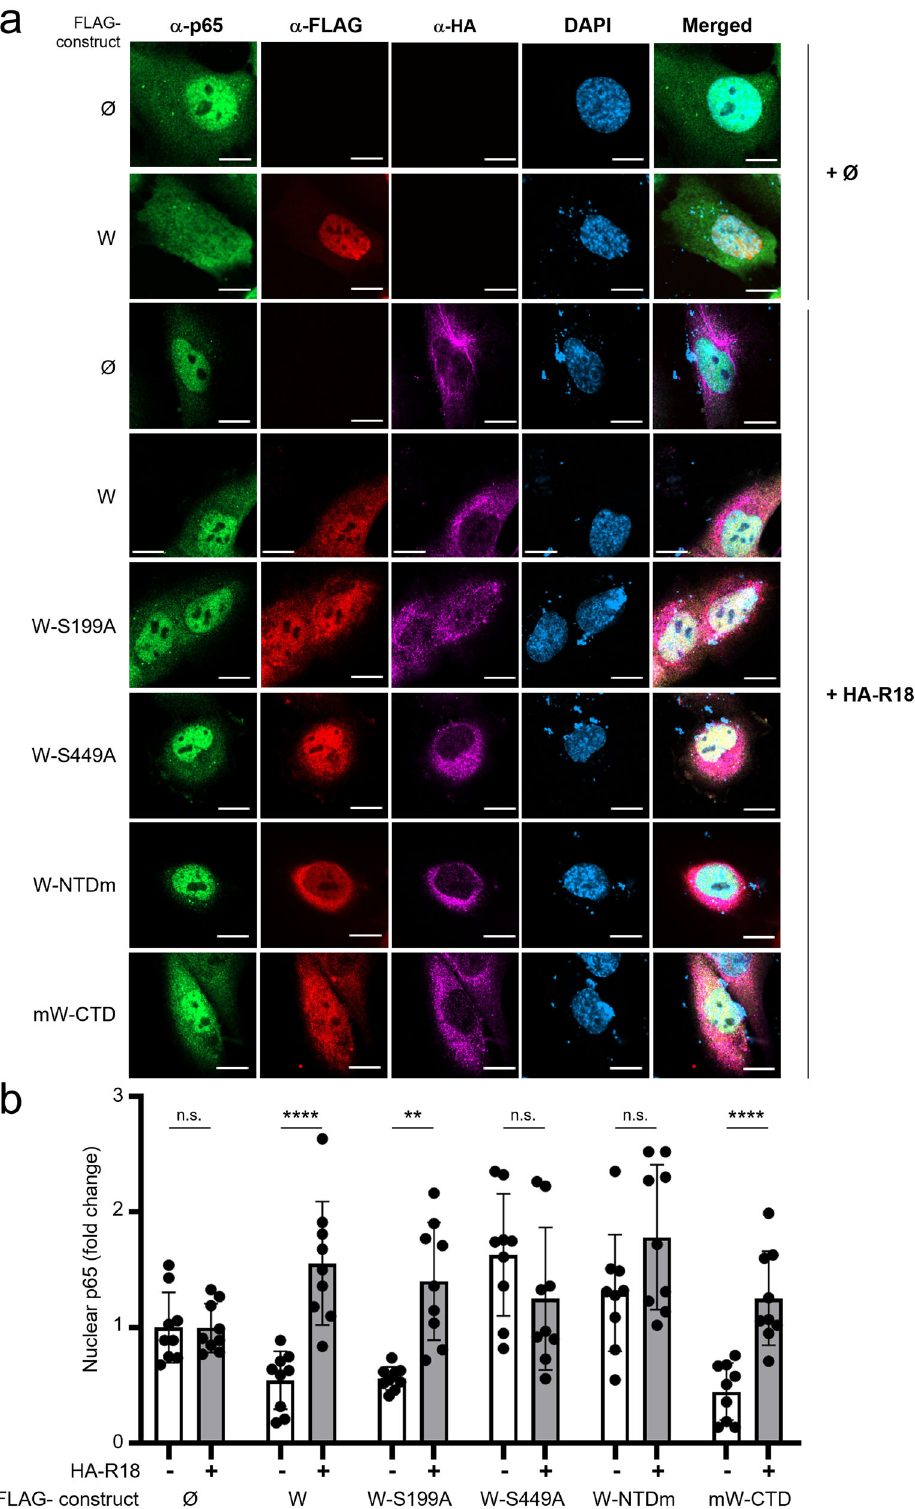
Fig. 5 Expression of the 14-3-3 inhibitory peptide R18 disables W protein induced inhibition of NF- κ B p65 nuclear localization. a Representative images of HPMEC cells transfected or not (Ø) with plasmids encoding HA-R18 and indicated FLAG-tagged W proteins, and stimulated with 10 ng/mL of IL-1 β for 20 min (scale bar = 10 µ m). Cells were fi xed and stained for NF- κ B p65, anti-HA, and anti-FLAG, and analyzed by confocal microscopy. b The mean fl uorescence intensity for p65 protein was measured in the cell nucleus. Signal obtained from W expressing cells (as labeled by anti-FLAG) was normalized to the signal from cells not labeled by anti-FLAG and expressed in fold change. Error bars represent the mean ’ s con fi dence interval (CI 95%) for nine cells, combined from three independent experiments. Each combination has been done in three different wells performed in two independent experiments. Statistical signi fi cance was assessed by a one-way unpaired ANOVA, multiple comparisons Tukey ’ s test; ** p < 0.01 and **** p < 0.0001.